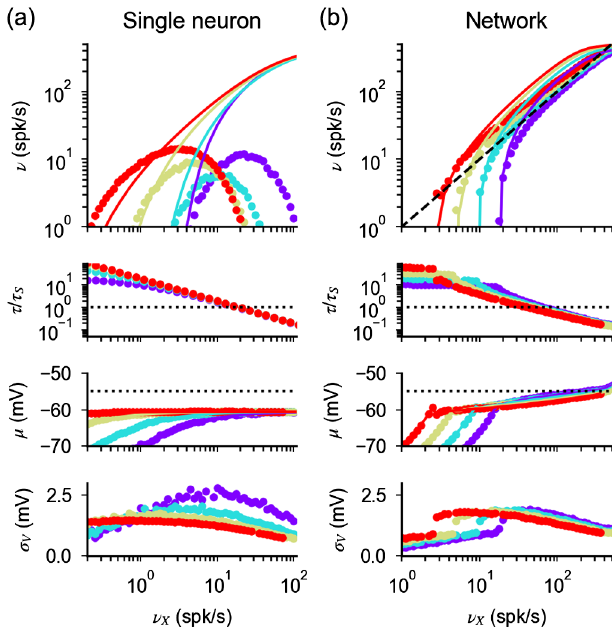
FIG. 7. Single-neuron and network response with finite syn- aptic time constants, when both a and τ (a) Single-neuron response as a function of input rate ν computed numerically from Eqs. (1) and (23). Different colors correspond to different values of K ( 10 3 , purple; 10 4 , light blue; 10 5 , yellow; 10 6 , red) with a and τ (26); for K ¼ 10 3 , a ¼ 0 . 01 and τ The scaling relation described in the main text preserves the response properties observed in Fig. 6. (b) Analogous to (a) but in the network case; colors correspond to K ¼ 500 , 10 3 , 2 × 10 3 , and 4 × 10 3 . For K ¼ 10 3 , a ¼ 0 . 002 and τ